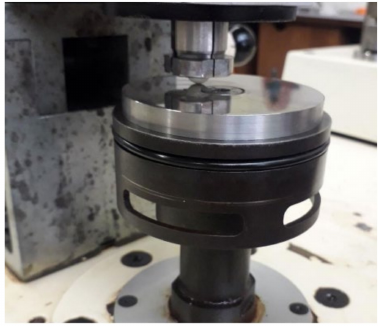
Figure 4. Sketch of the pin-on-disk. The dimensions of the pin were 32 mm (l) × 10 mm (dia) and dimensions of the disk were 8 mm (l) × 163 mm